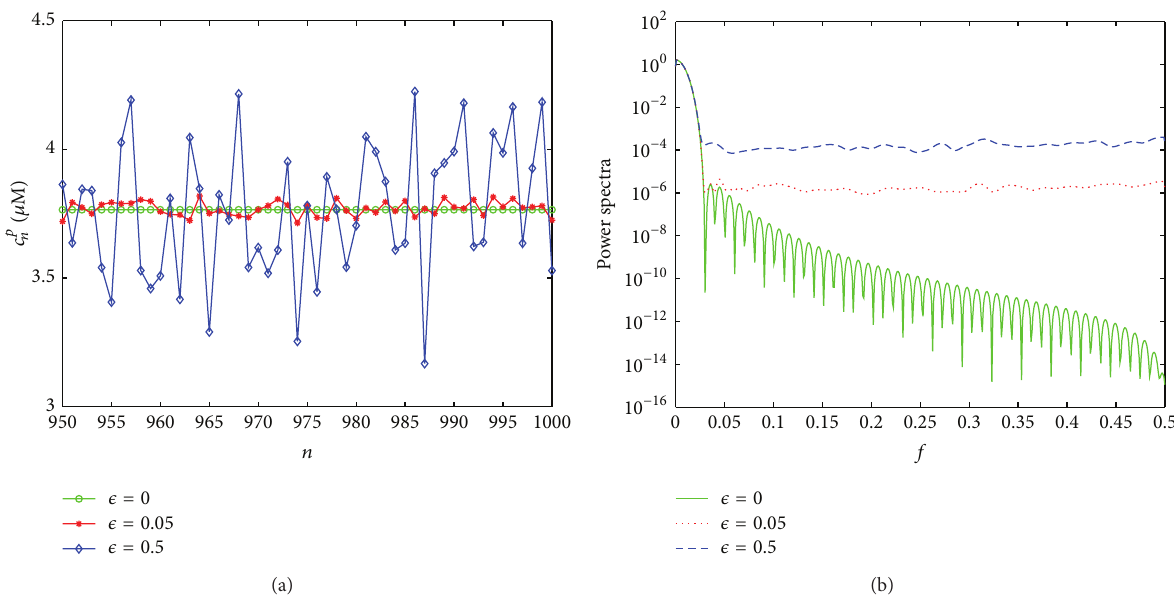
Figure 4: (a) Time series of system (11) for different noise intensities 𝜖 = 0, 𝜖 = 0.01 , and 𝜖 = 0.1 , respectively, where the total calcium 𝑐 𝑡 = 1.9 and the other parameters are the same as Figure 1(a). (b) Power spectra corresponding to the time series in (a).